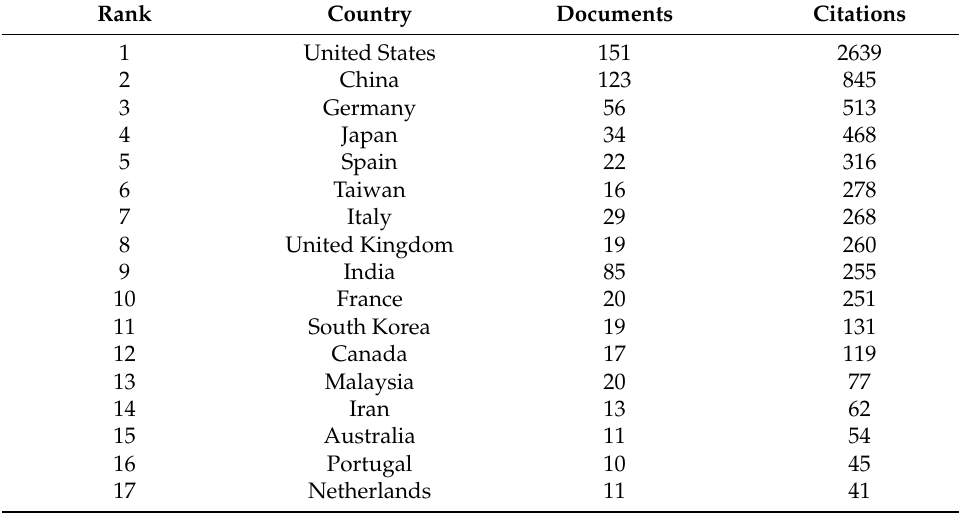
Table 5. Most influential